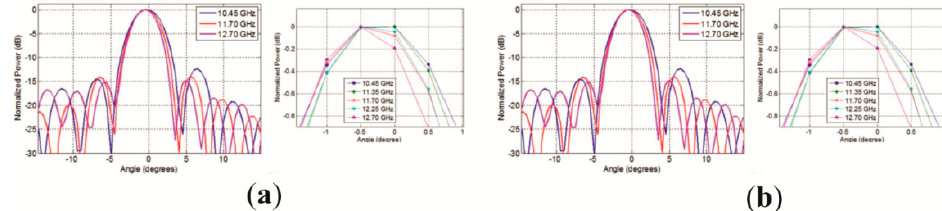
Figure 20. Squint of the main lobe of the antenna shown in Figure 18 as a function of the frequency [61]: ( a ) E-plane; ( b ) H-plane.